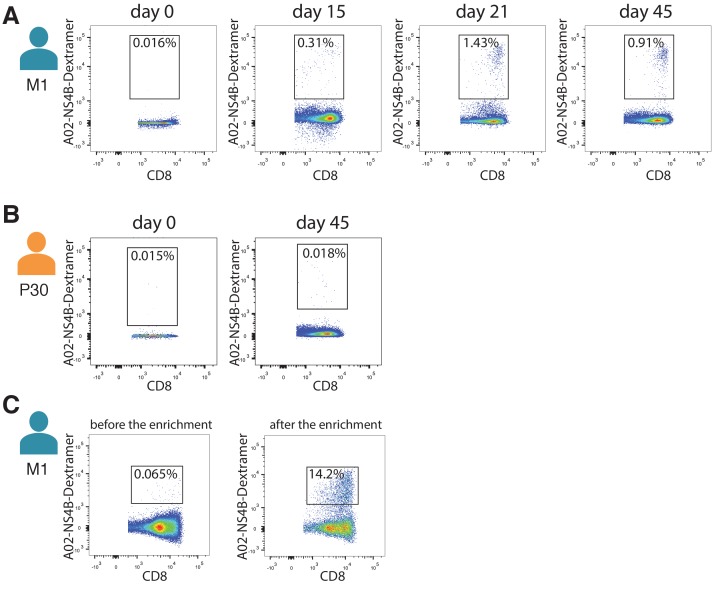
Isolation of NS4B-specific T-cells.Isolation of NS4B-specific T-cells of donor M1 (A) and donor P30 (B) on different timepoints after YF vaccination. (C) Number of NS4B-dextramer-positive cells before (left) and after (right) enrichment on the magnetic beads. FACS was performed on donor M1 before the second immunization.